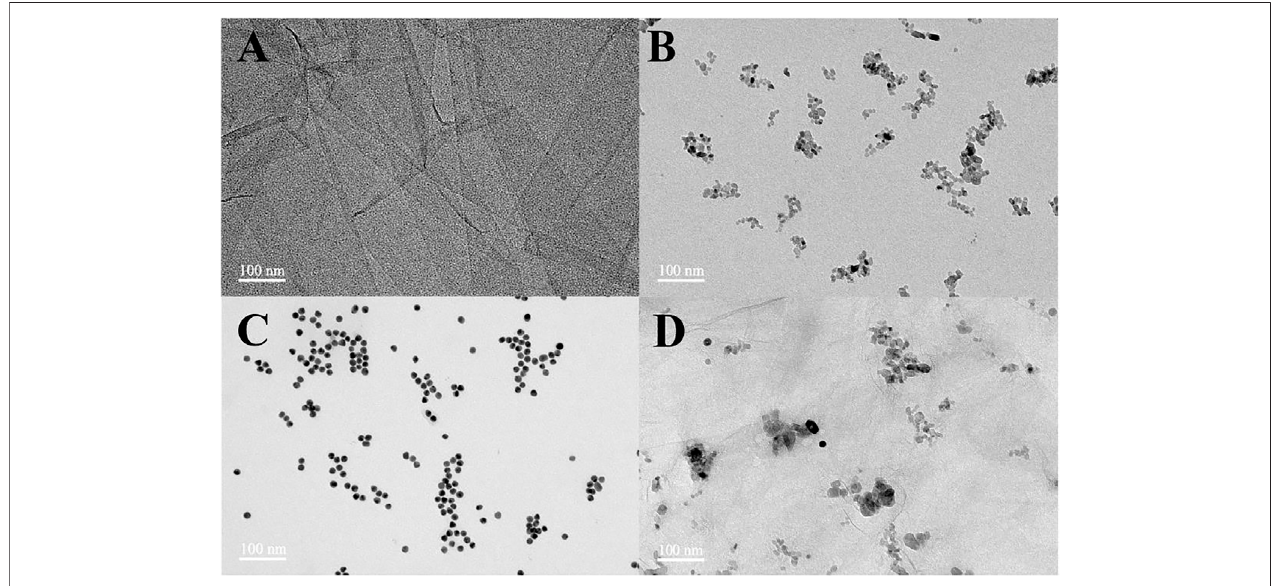
FIGURE 1 | TEM images of GO (A) , TiO 2 nanoparticles (B) , Au nanoparticles (C) , and rGO – TiO 2 – Au nanocomposites (D) .